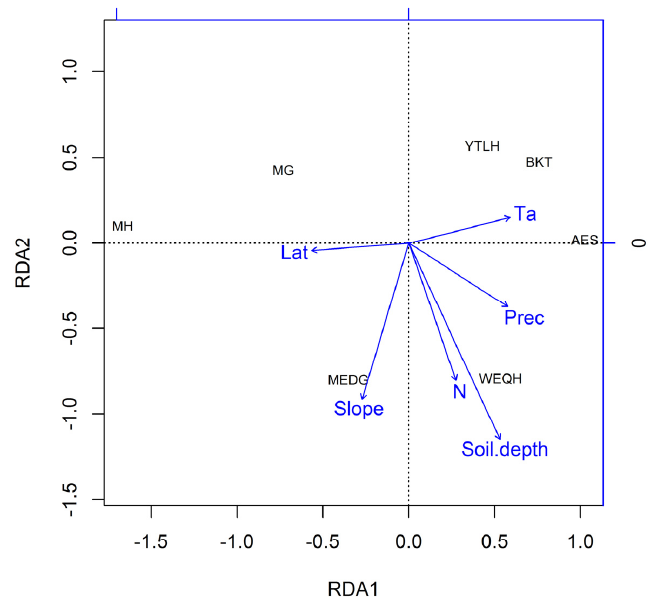
Figure 5. Redundancy analysis (RDA) calculated from the seven residual chronologies, local factors, and the monthly climate parameters for the period 1960–2013. Significant ( p < 0.05) environmental factors are indicated by vectors (blue arrows); the longer the vector, the more important the climate parameter. The correlation between the variables is illustrated by the cosine of the angle between two vectors. Vectors at sharp angles indicate a positive correlation, vectors at obtuse angles indicate a negative correlation, and vectors crossing at right angles indicate a near ‐ zero correlation [33]. Ta = annual mean temperature, Prec = annual total precipitation, N = soil organic nitrogen content. Slope = the slope of the sampling point, Soil depth = the depth of the soil layer at the sampling point, Lat = the latitude of the sampling point. MH, MG, MEDG, YTLH, WEQH, BKT, and AES represent the seven sampling sites (i.e., Mohe, Mangui, Moerdaoga, Yitulihe, Wuerqihan, Boketu, and Aershan, respectively). Table 3. Correlation matrix for the standard ring ‐ width chronologies for the seven sampling sites, 1960–2013 (all values significant at p < 0.05).